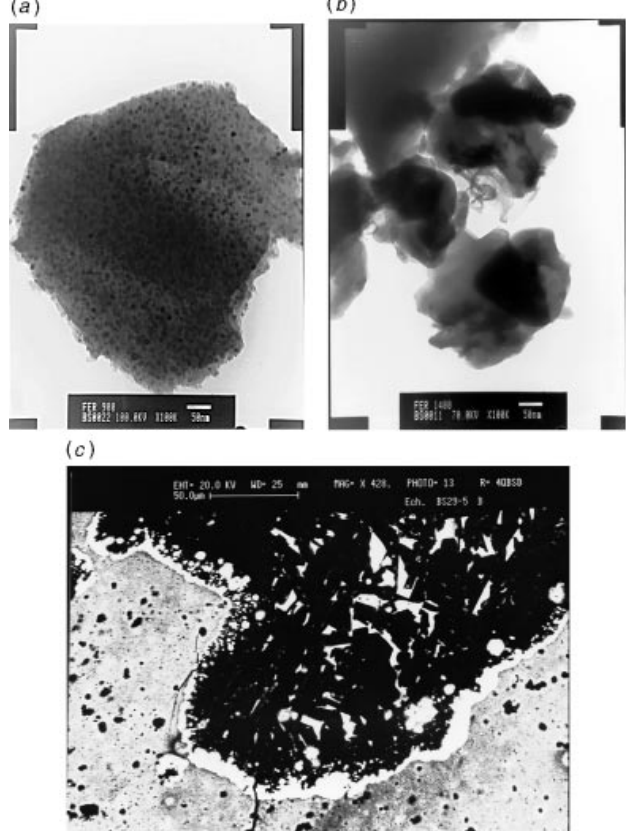
Figure 4. (a) TEM photograph of a 1000 °C sample, (b) TEM photograph of a spherical metallic particle, and (c) BEI photograph of an interfacial melting zone observed in a 1400 °C sample. From Ref. [62], Reproduced by permission of The Royal Society of